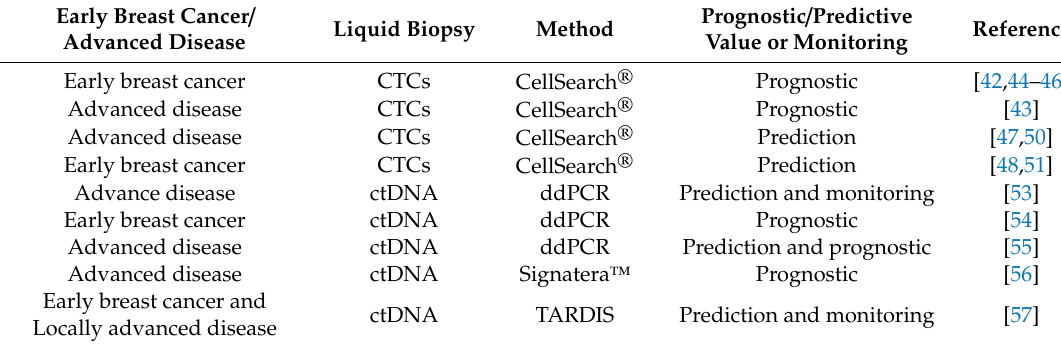
Table 2. Examples of studies demonstrating the clinical relevance of circulating tumor cells and